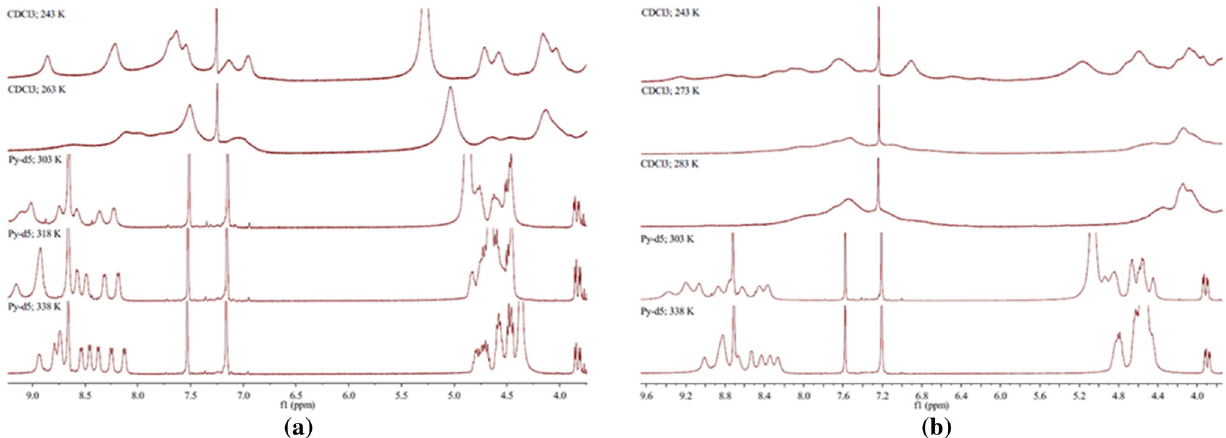
Fig. 2 1 H NMR of compounds 1 ( a ) and 2 ( b ) at different